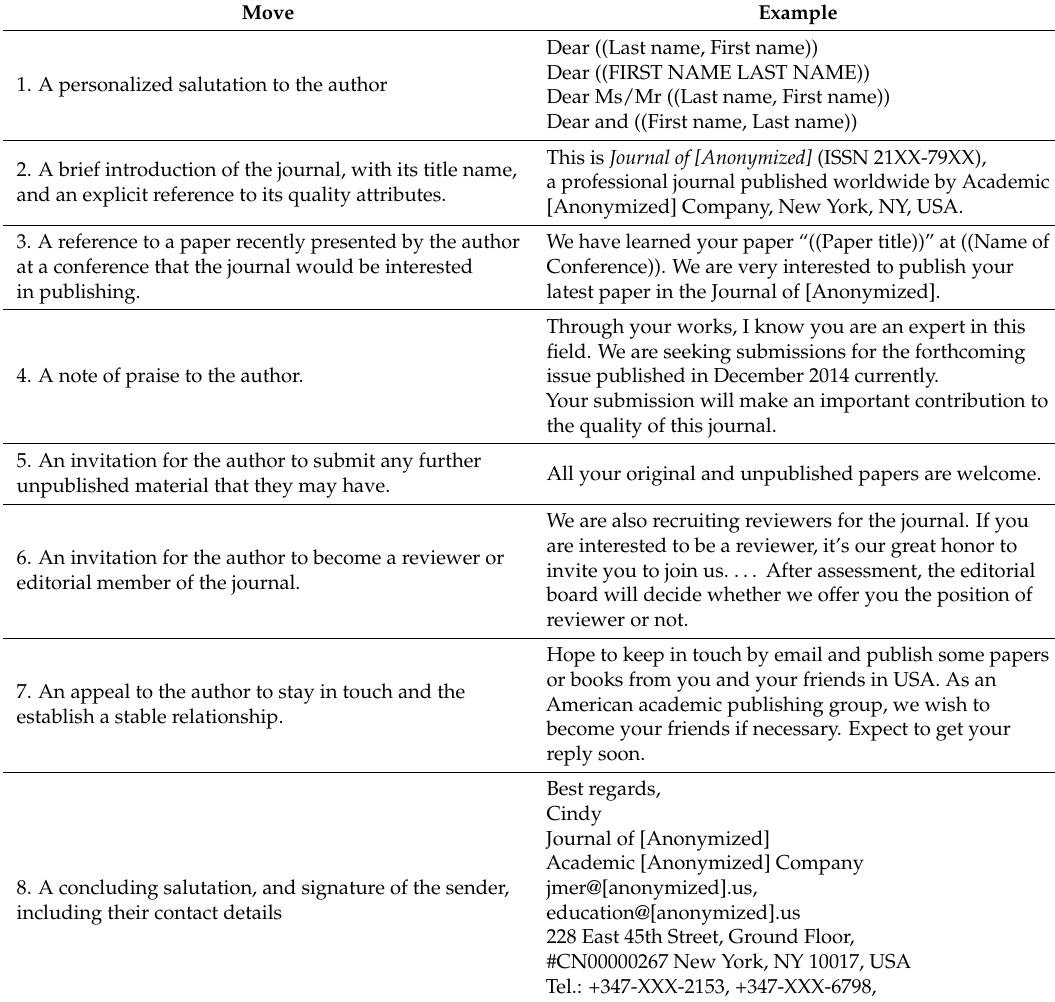
Table 1. Rhetorical moves of contact emails from predatory journals, with examples from our data. Move